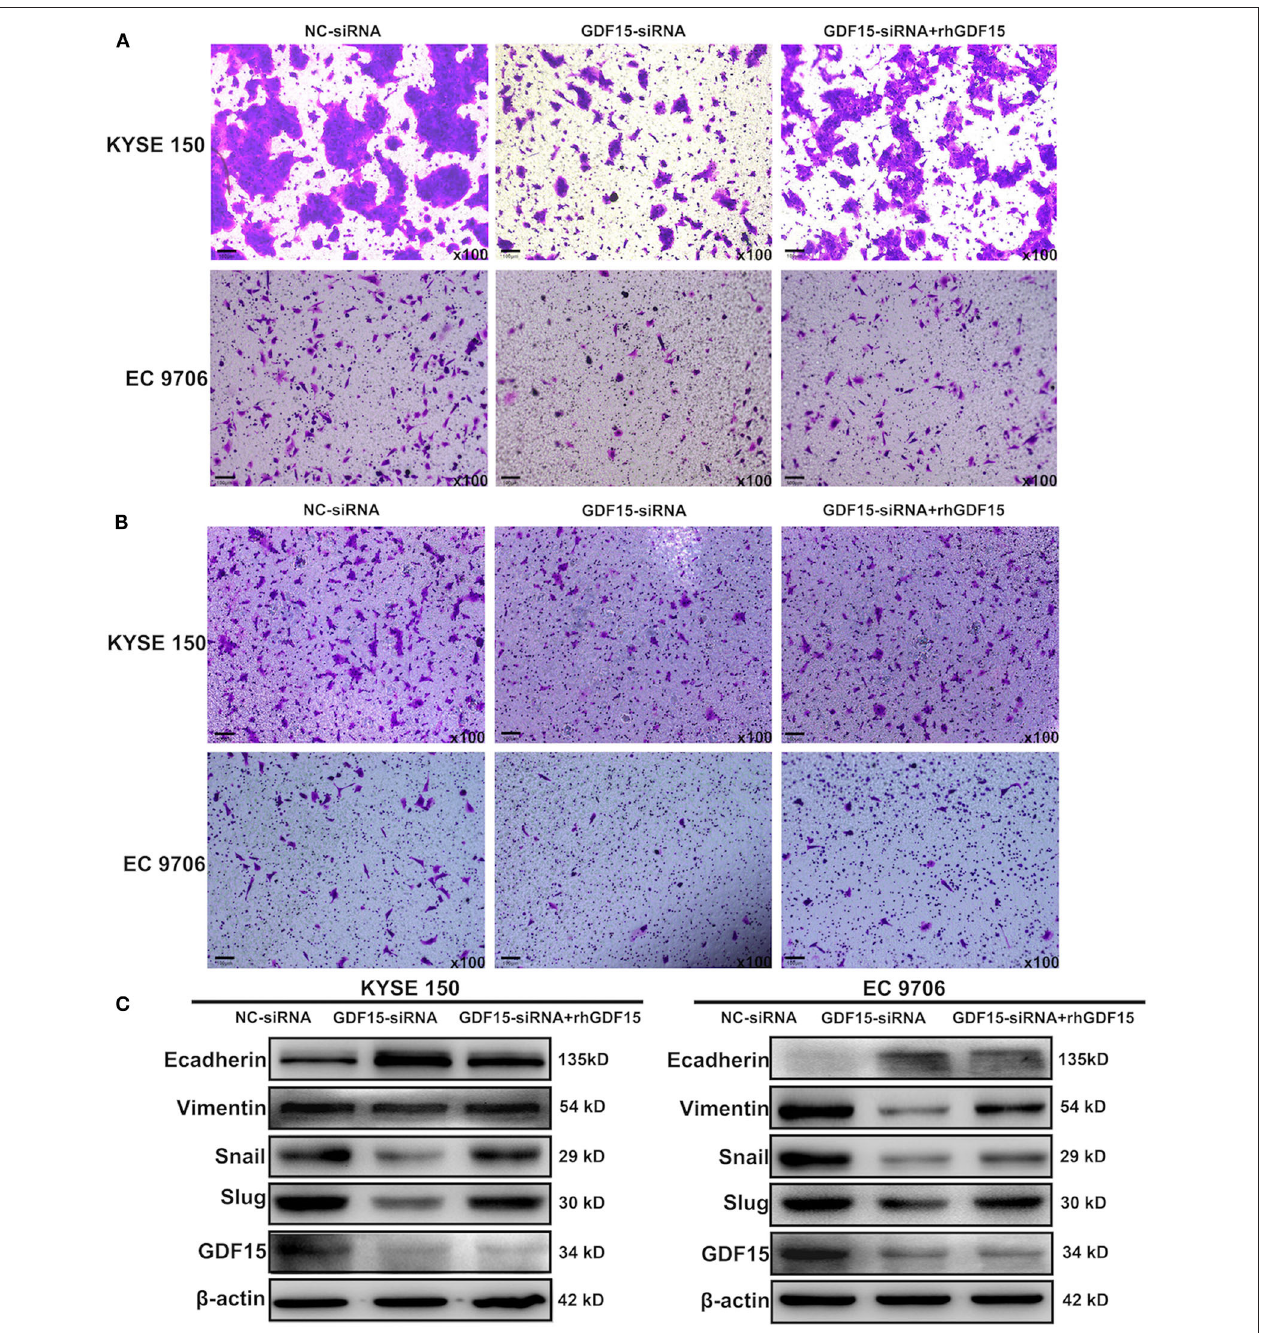
FIGURE 2 | Role of GDF15 in invasion and EMT of ESCCs (NC-siRNA, GDF15-siRNA, GDF15-siRNA + rhGDF15). (A,B) Effect of GDF15 on migration and invasion determined using transwell chamber assays. (C) Expression levels of EMT related proteins E-cadherin, vimentin, snail, and slug determined by western blot.